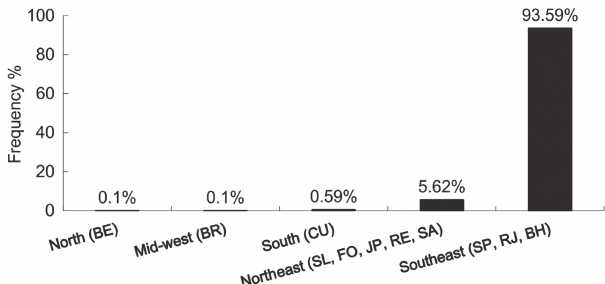
Fig. 5. Five Brazilian geopolitical regions and the 11 big cities (BE - Belém, BR - Brasília, CU - Curitiba, SL - São Luís, FO - Fortaleza, JP - João Pessoa, RE - Recife, SA - Salvador, SP - São Paulo, RJ - Rio de Janeiro, BH - Belo Horizonte) where hobbyists traded juveniles of non-native large fish, between May-2012 and September-2016.